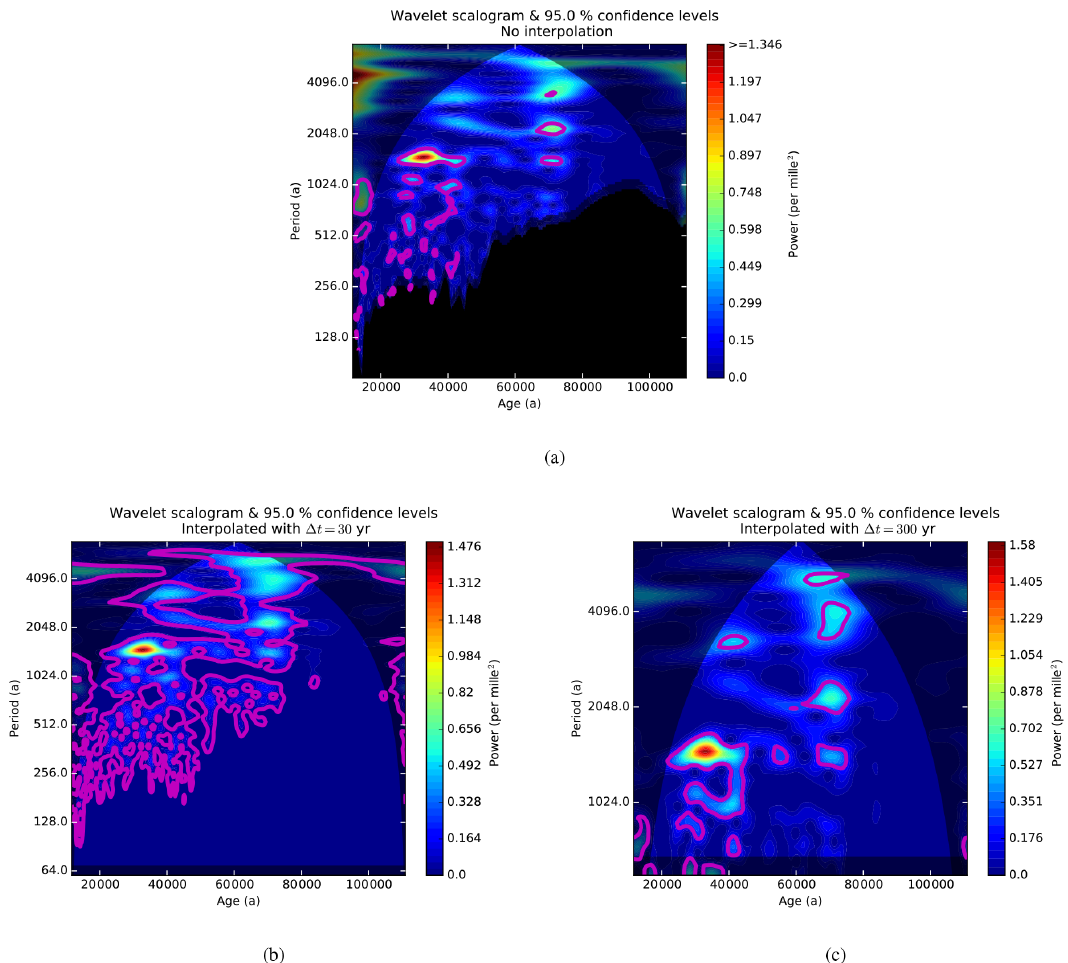
Figure F3. Scalogram of the time series presented in Fig. F1 and the 95% analytical confidence levels against a red noise. (a) Raw time series. (b) Interpolated time series with (cid:49)t = 30yr. (c) Interpolated time series with (cid:49)t = 300yr.